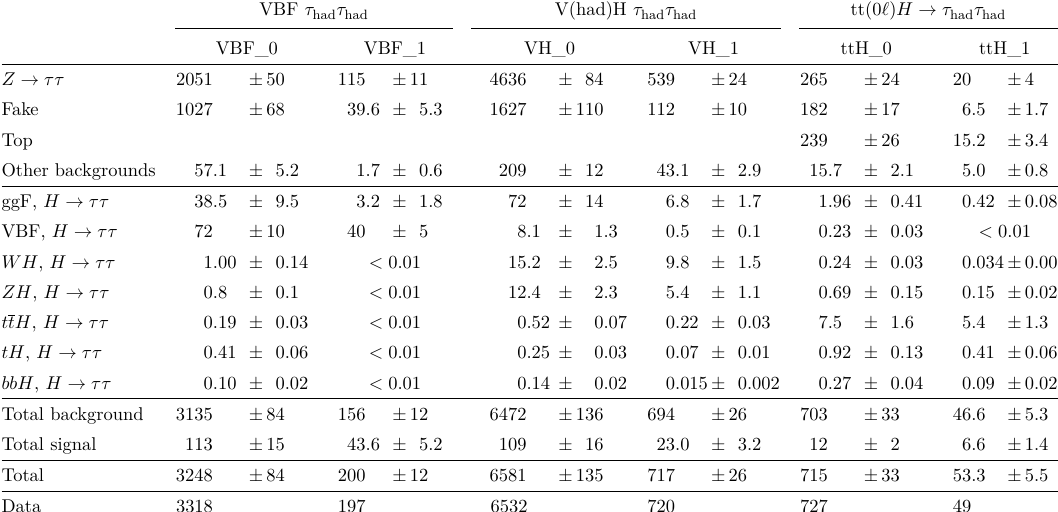
Table 8. Observed event yields and predictions as computed by the fit in the VBF, V(had)H and tt(0 ‘ ) H → τ τ signal regions of the τ τ channel. In the VBF and V(had)H categories, had had had had the top processes are estimated with the other backgrounds (diboson, H → WW ∗ ) by the fit. Uncertainties include statistical and systematic components. The prediction for each sample is determined from the likelihood fit performed to measure the pp → H → ττ cross-section.